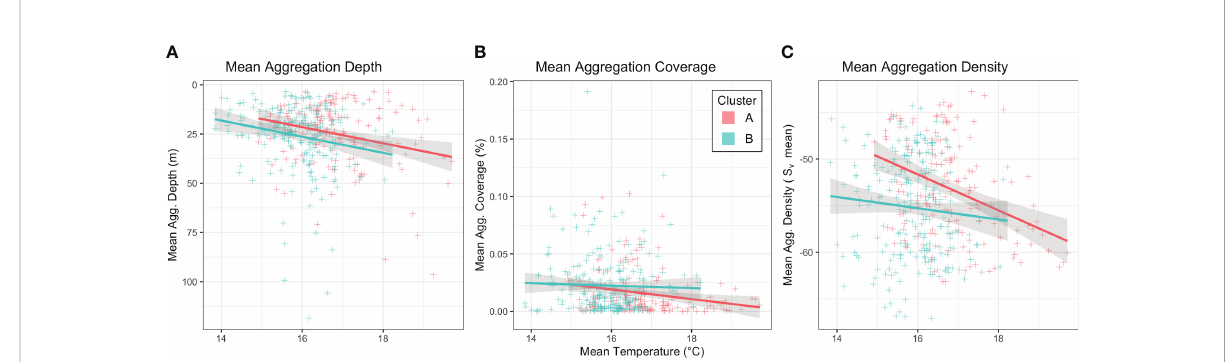
FIGURE 7 Scatter plots of CTD mean temperature (°C) plotted against the acoustic aggregation characteristics metrics being (A) mean aggregation depth (mean depth of aggregation centre), (B) aggregation coverage (% of sampled area occupied by acoustic aggregations), and (C) aggregation internal density (mean Sv within aggregation boundaries). The slope of the generalised linear models are shown with colour representing the two seascape classi fi